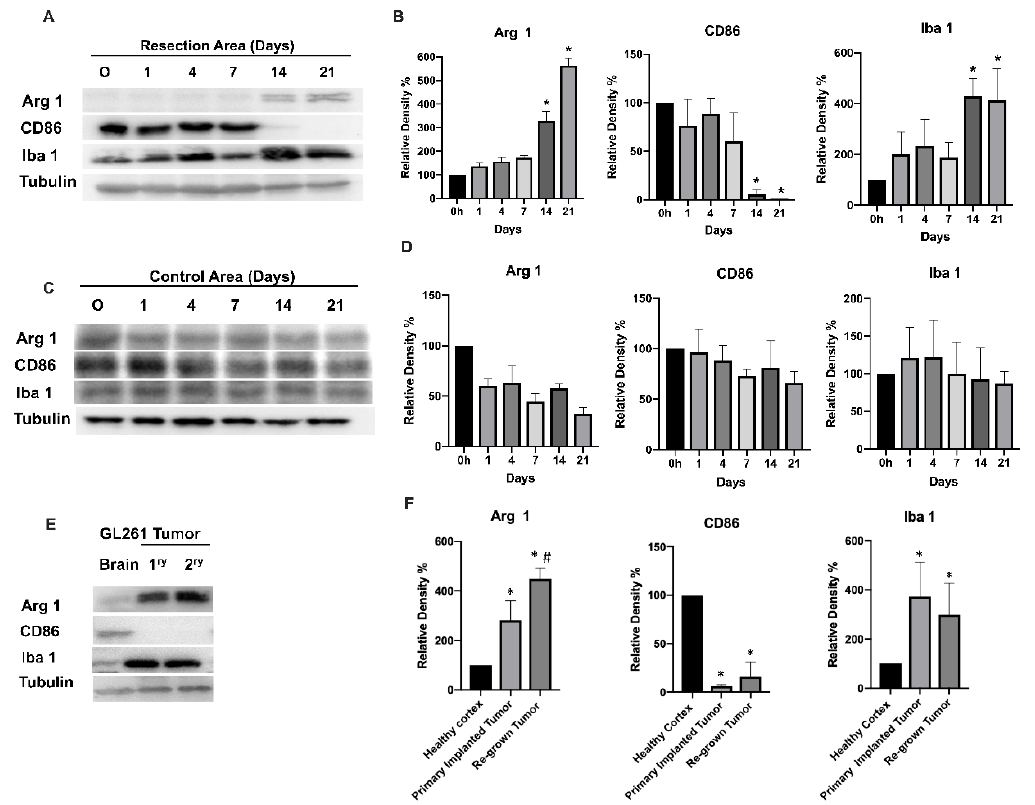
Figure 1. Western blot analysis ( A , C , E ) and quantification ( B , D , F ) of myeloid cell markers at the brain tumor resection site and in control cortex from the contralateral hemisphere. The Gl261/C57Bl/6 mouse glioma implantation model was used. Time points 0, 1, 4, 7, 14, and 21 days after tumor resection are shown for the tumor resection site ( A , B ) and for healthy cortex from the contralateral hemisphere ( C , D ). Comparative expression of myeloid cell markers is shown for healthy cortex in the contralateral hemisphere for a primary implanted tumor (1ry) and for a tumor regrown after resection (2ry; E , F ). Mean + S.E., and significant differences between groups are shown ( p < 0.005). *, a significant difference from 0 h after resection ( B , D ) or to healthy cortex ( F ); #, a significant difference between primary implanted (1ry) and regrown (2ry) tumors. ( N =